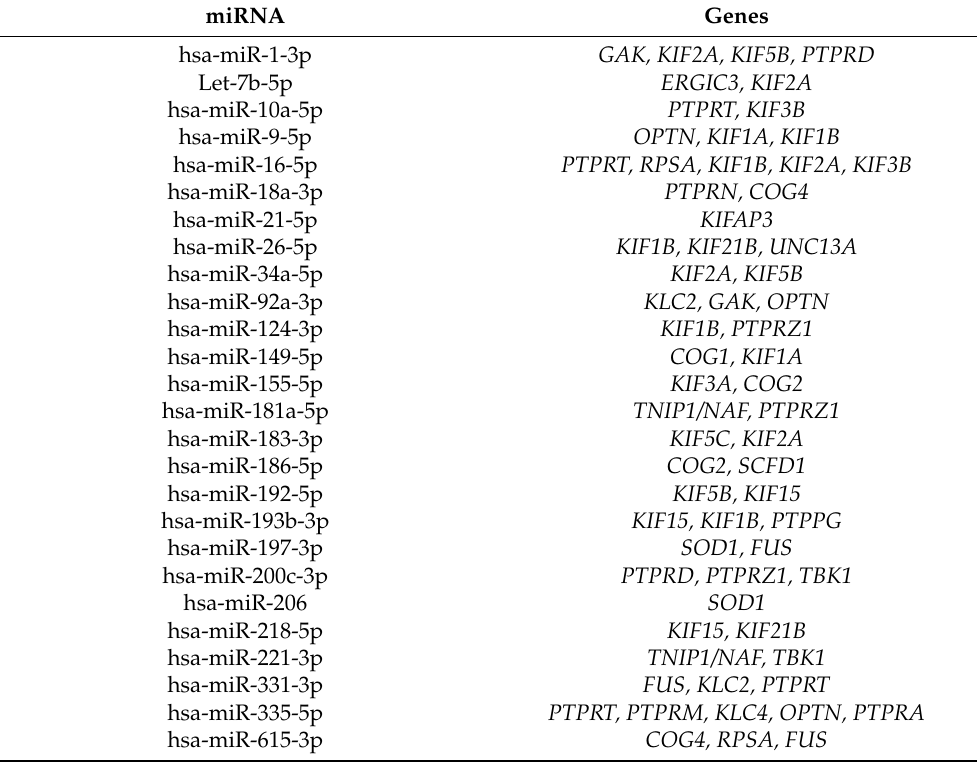
Table 3. miRNAs that regulate the expression of genes that code proteins differentially distributed in P5 and P18 opossum spinal cords and detected in association with ALS. (data from miRTarBase (https://miRTarBase.cuhk.edu.cn/) (accessed on 1 July 2022) and [18,19,71–73]). miRNA Genes hsa-miR-1-3p GAK, KIF2A, KIF5B, PTPRD Let-7b-5p ERGIC3, KIF2A hsa-miR-10a-5p PTPRT, KIF3B hsa-miR-9-5p OPTN, KIF1A,